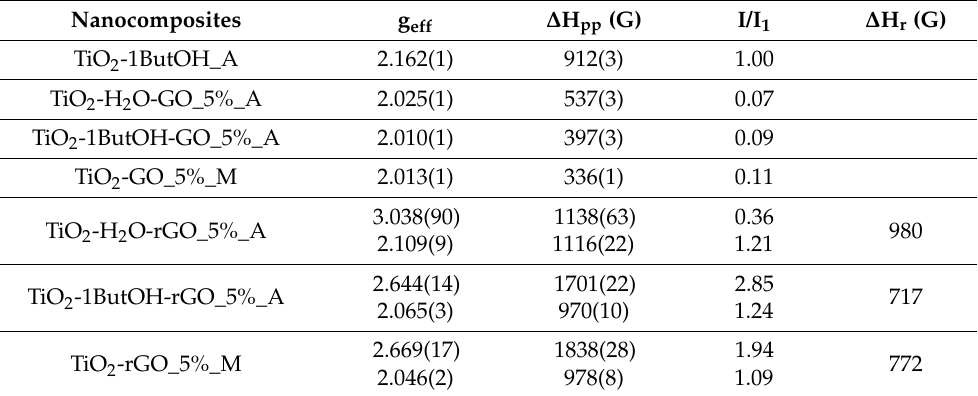
Table 1. The parameters: g eff , line width, integrated intensity, and the difference between resonance fields for modified nanocomposites TiO 2 at room temperature.